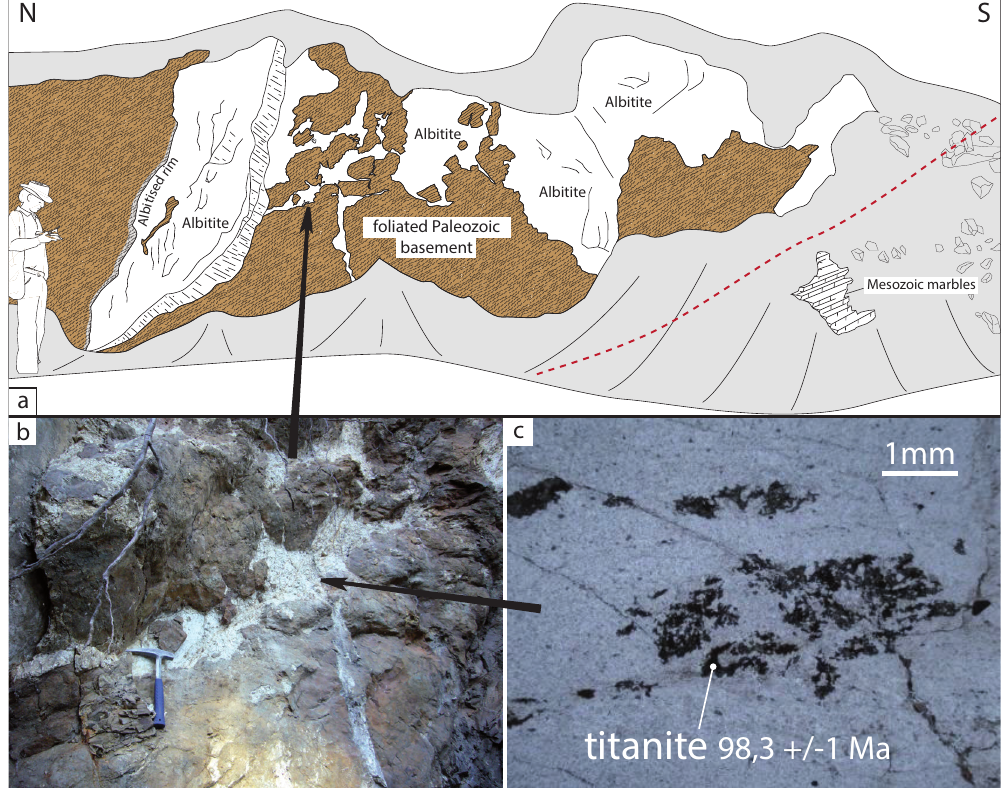
Figure 12. Albitite veins intruding the Paleozoic basement at Arguenos–Moncaup (localized at point 594 near Cazaunous in Fig. 6).